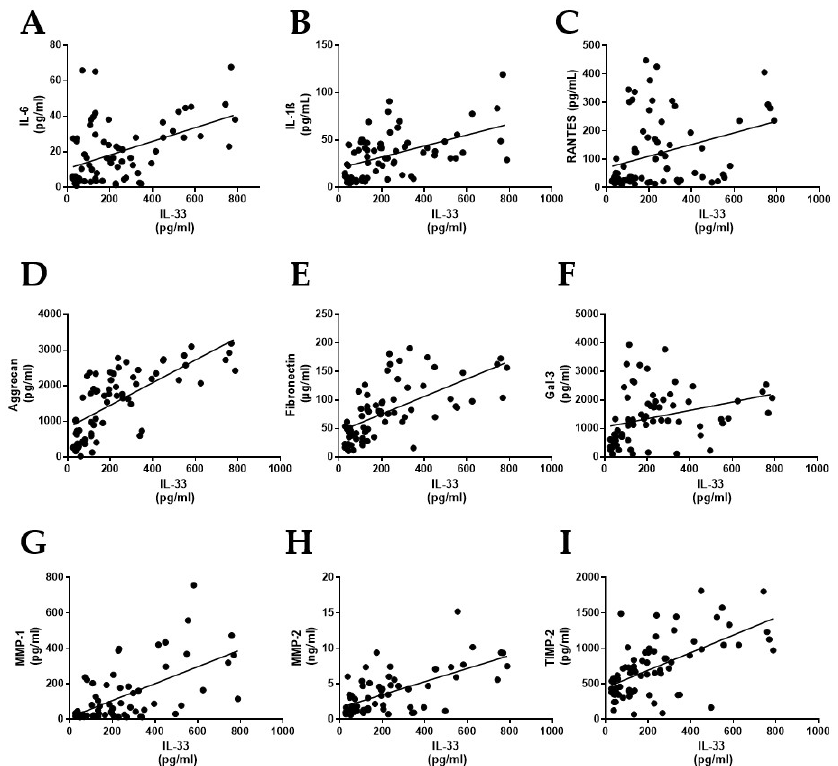
Figure 2. Correlations between IL-33 protein levels and principal features that characterize human myxomatous mitral valves. Correlation between valve tissue levels of IL-33 and IL-6 ( r = 0.468, p < 0.0001) ( A ), IL- 1β ( r = 0.496, p < 0.0001) ( B ), RANTES ( r = 0.331, p = 0.0037) ( C ), aggrecan ( r = 0.711, p < 0.0001) ( D ), fibronectin ( r = 0.634, p < 0.0001) ( E ), Gal-3 ( r = 0.314, p < 0.0076) ( F ), MMP-1 ( r = 0.618, p < 0.0001) ( G ), MMP-2 ( r = 0.638, p < 0.0001) ( H ) and TIMP-2 ( r = 0.606, p < 0.0001) ( I ). Protein data in pg/mL. IL-33: Interleukin-33; IL-6: Interleukin-6; IL-1 β : Interleukin-1 beta; Gal-3: Galectin-3; MMP-1: Matrix metalloproteinase-1; MMP-2: Matrix metalloproteinase-2: TIMP-2: Tissue inhibitor of metalloproteinase-2.